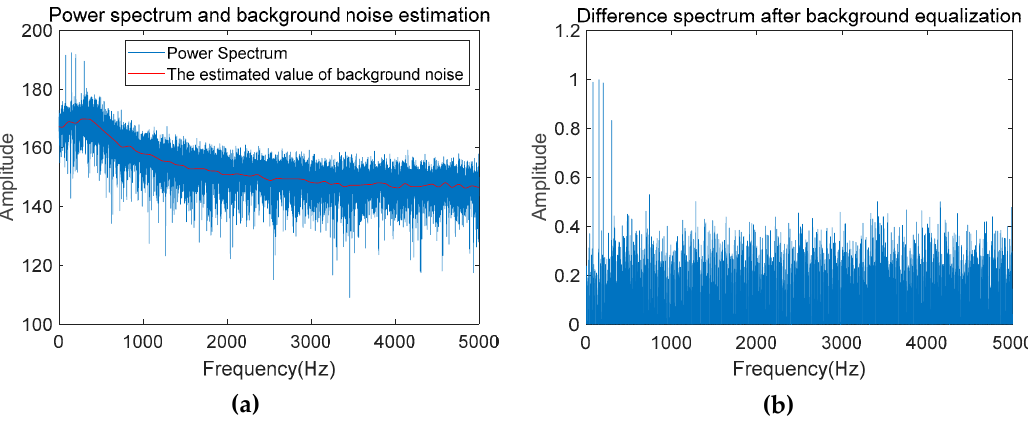
Figure 9. Comparison of power spectrum data: (a) Before background equalization; (b) After background equalization.